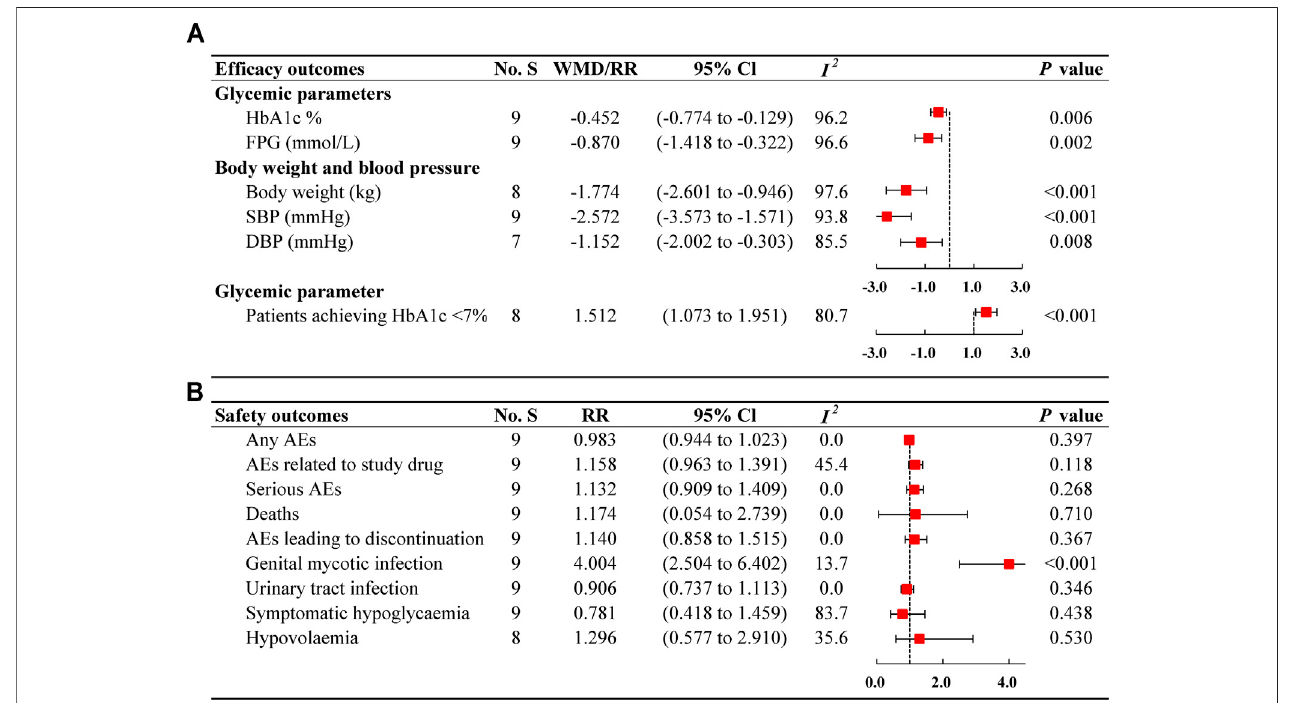
FIGURE 2 | Forest plots of ertugli fl ozin on ef fi cacy (A) and safety (B) outcomes. No. S, numbers of studies; WMD, weighted mean difference; CI, con fi dence interval;I2,heterogeneity;HbA1c,glycatedhaemoglobin;FPG,fastingplasmaglucose;SBP,systolicbloodpressure;DBP,diastolicbloodpressure;RR,riskratio;AEs, adverse